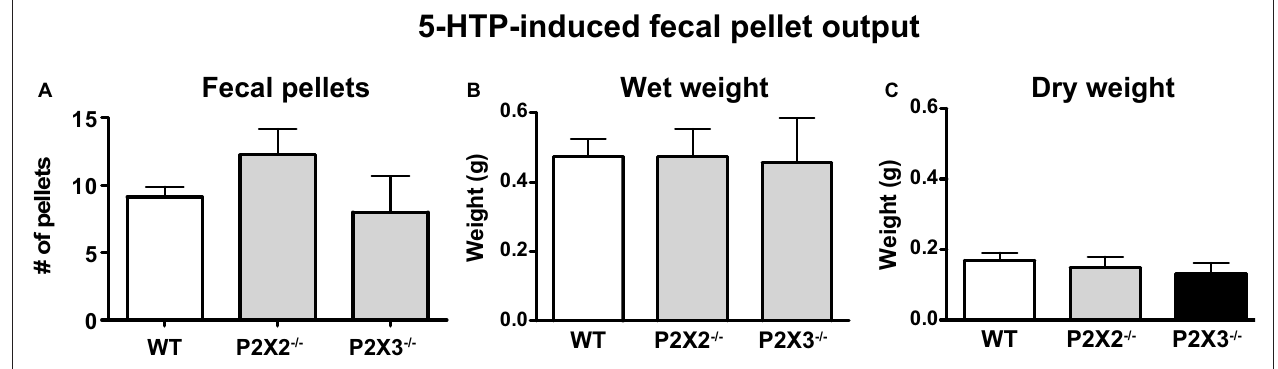
Figure 6 | 5-HTP induced fecal pellet output is similar in WT ( n = 8) and P2X2 ( n = 4) and P2X3 ( n = 4) subunit KO mice. (A) Number of fecal pellets expelled. (B) Total wet weight of fecal pellets expelled by each group. (C) Dry weight of fecal